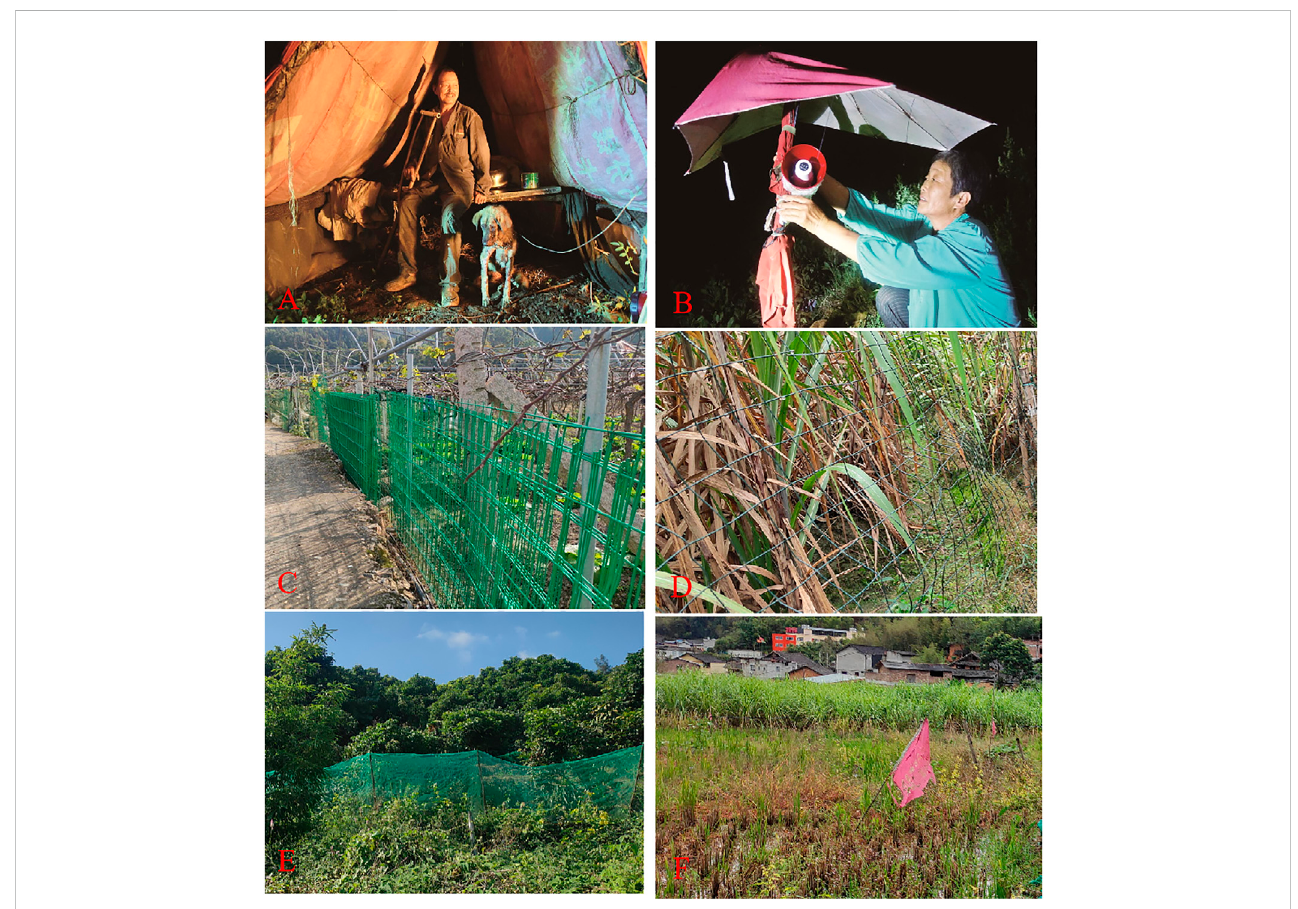
FIGURE 4 Protective measures adopted by rural households: (A) Human guarding (B) Repulsion by a loudspeaker (C, D) Wire mesh fence (E) Plastic net fence (F) Repulsion by a red banner.